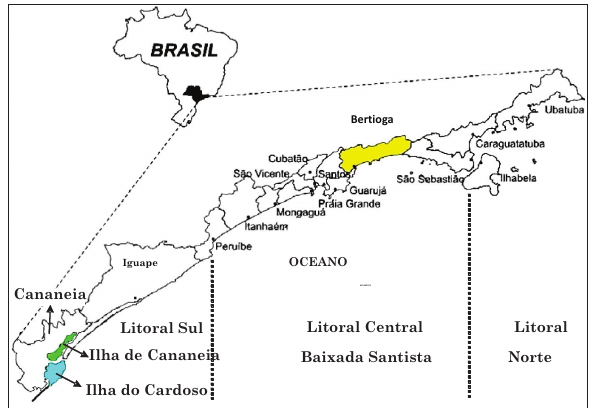
Figura 1. Localização dos municípios e locais amostrados no litoral do Estado de São